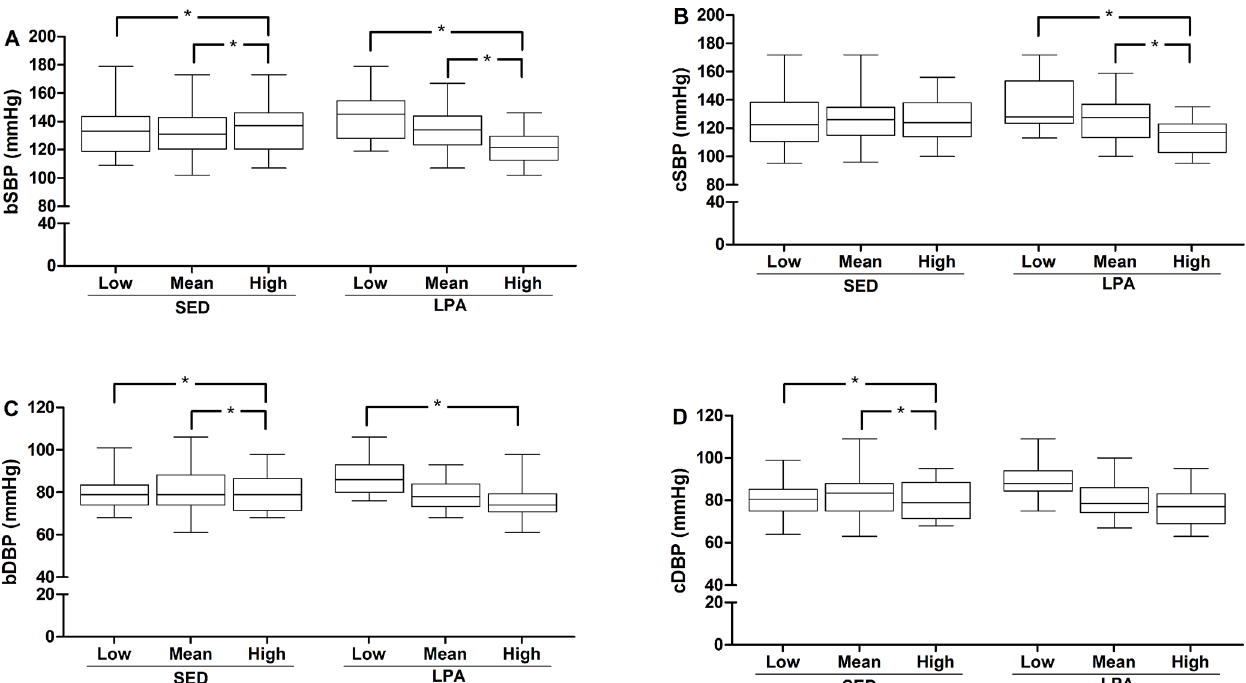
Fig 1. Comparison of blood pressure among tertiles of minutes spent in sedentary activities and in light physical activities. bSBP = brachial systolic blood pressure; bDBP = brachial diastolic blood pressure; cSBP = central systolic blood pressure; cDBP = central diastolic blood pressure. For sedentary activities, low is < 492.42; mean is 492.42 – 570.67; and high is > 570.67 min/day. For light physical activities, low is < 297.54; mean is 297.54 – 356.86; and high is > 356.86 min/day. Note : All analyses were adjusted for sex, age, trunk fat, number of antihypertensive drugs, accelerometer wear time and moderate- to-vigorous physical activities.